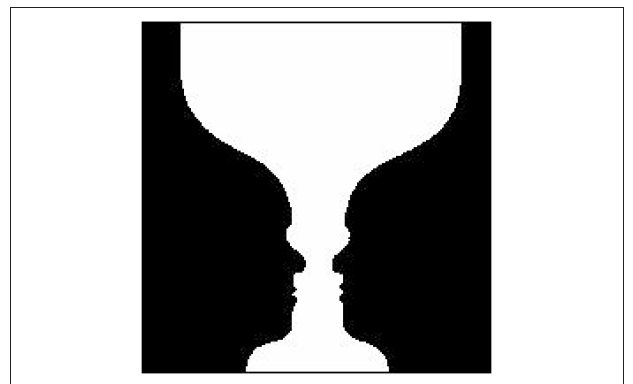
FIGURE 11 | Ambiguity Figure